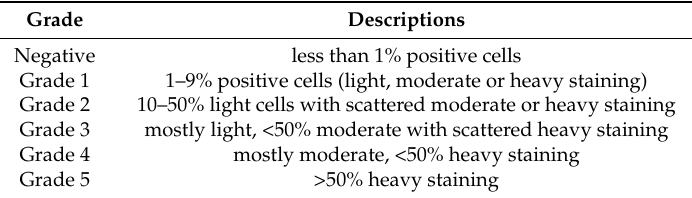
Table 2. Immunohistochemistry grading